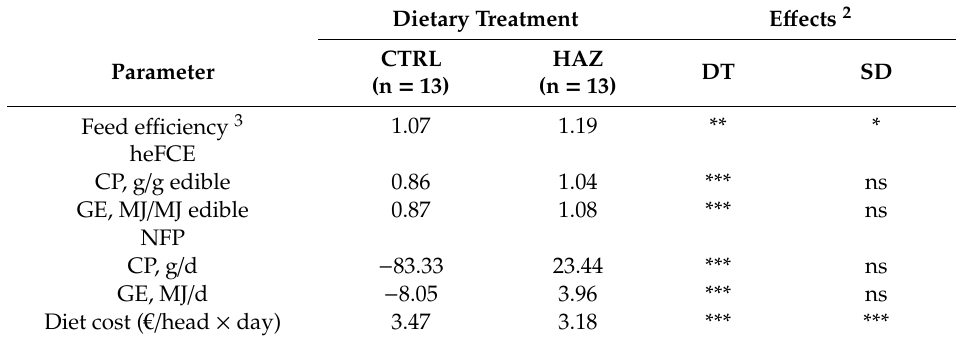
Table 7. Feed e ffi ciency, human-edible feed conversion e ffi ciency indexes, and net food production of cows fed the control (CTRL) and hazelnut skin (HAZ) diets 1